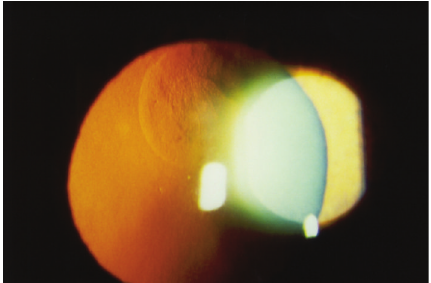
Figure 2: Slitlamp photograph showing circumscribed protrusion of the posterior corneal curvature with concomitant stromal thinning and an opacification of the overlying stroma.